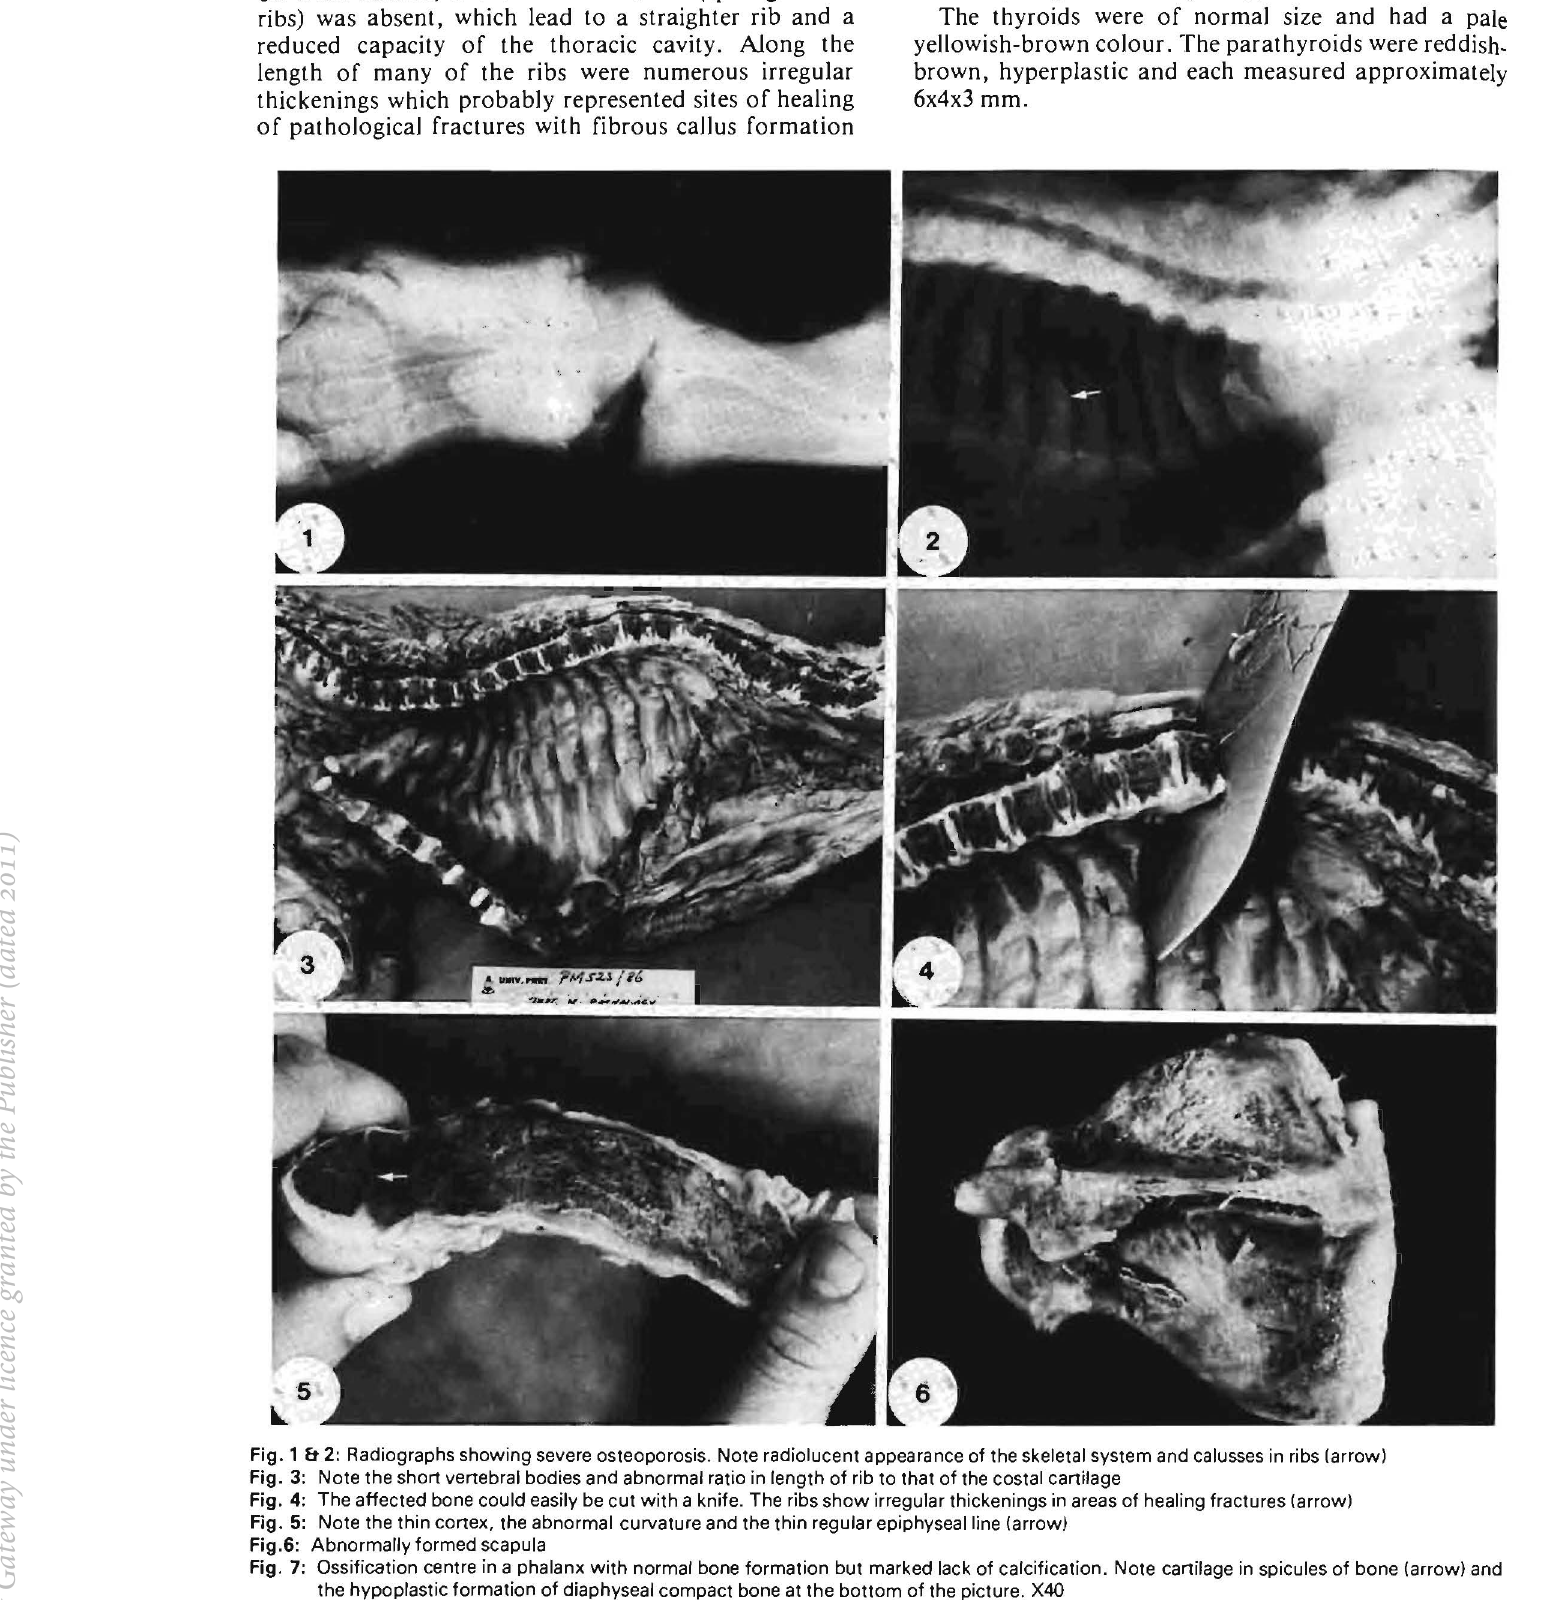
Fig.1 & 2: Radiographs showing severe osteoporosis. Note radiolucent appearance of the skeletal system and calusses in ribs (arrow) Fig. 3: Note the short vertebral bodies and abnormal ratio in length of rib to that of the costal cartilage Fig. 4: The affected bone could easily be cut with a knife. The ribs show irregular thickenings in areas of healing fractures (arrow) Fig. 5: Note the thin cortex, the abnormal curvature and the thin regular epiphyseal line (arrow) Fig.6: Abnormally formed scapula Fig. 7: Ossification centre in a phalanx with normal bone formation but marked lack of calcification. Note cartilage in spicules of bone (arrow) and the hypoplastic formation of diaphyseal compact bone at the bottom of the picture. X40 Fig. 8 & 10: Thickened periosteum and fibrous tissue in spicules of poorly mineralised osteoid along the diaphysis. X40 Fig. 9: Fracture with collagenous callus formation. X40 Fig. 11 & 12: Spicules of bone embedded in fibrous tissue in periosteal area and reticular connective tissue in medullary area. Note scant haemopoietic activity and few osteoblasts around some bony spicules (arrow). X200 Fig. 13: Thyroid showing C-cell hyperplasia (arrow!. X400 Fig. 14: Hyperplasia of the parathyroid. X400 (All magnifications given are the originals used during microphotography.) TYDSKRIF VAN DIE SUJD-AFRIKAANSE VETERINERE VERENIGING - JUNIE